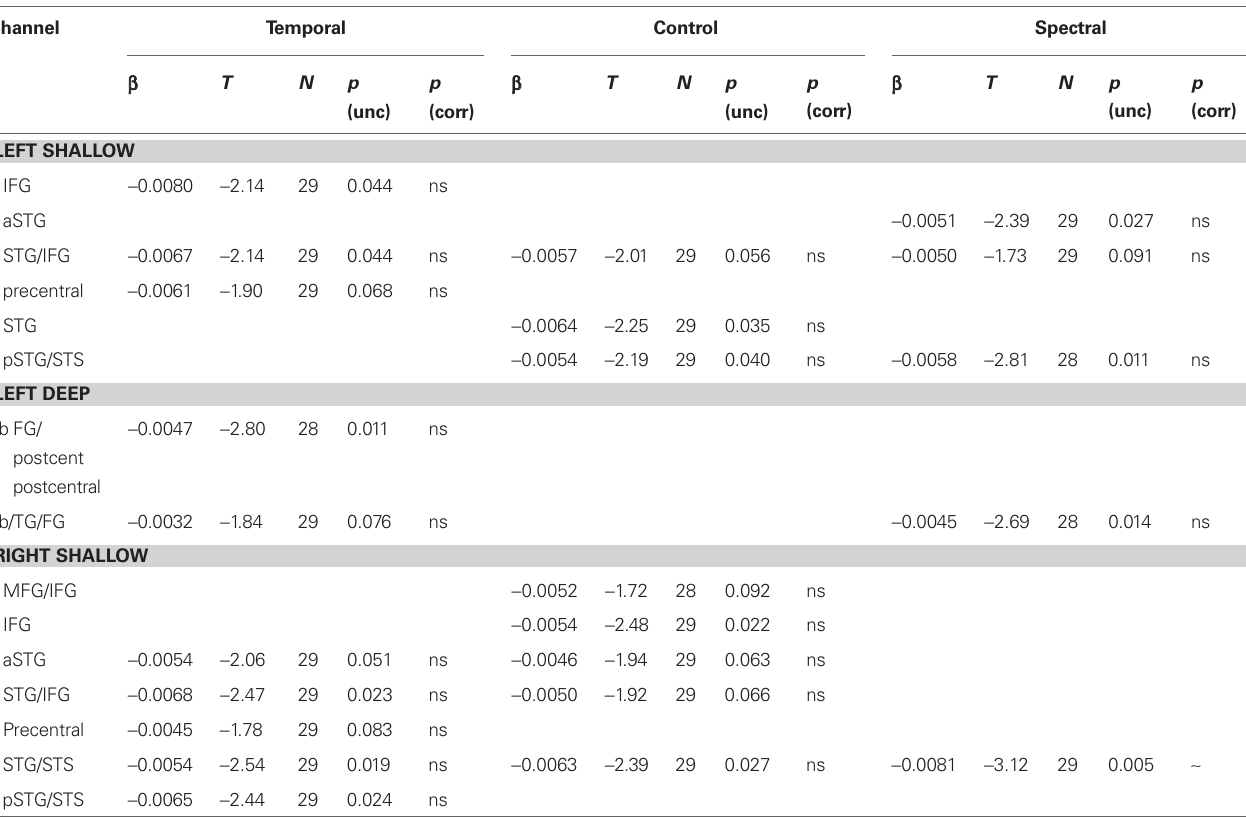
Table a1 | Levels of activations (deoxy-Hb changes) for temporal, control and spectral conditions. Channel